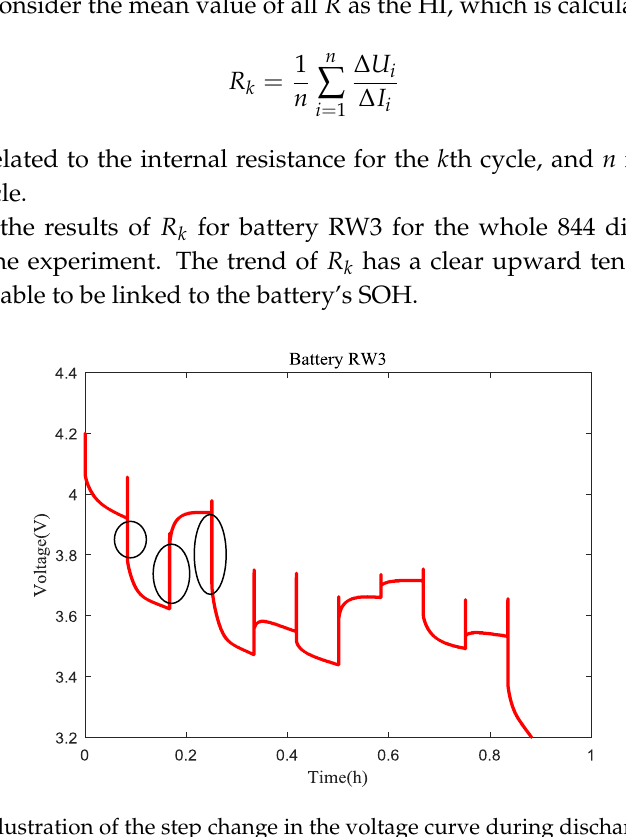
Figure 7. Illustration of the step change in the voltage curve during discharge